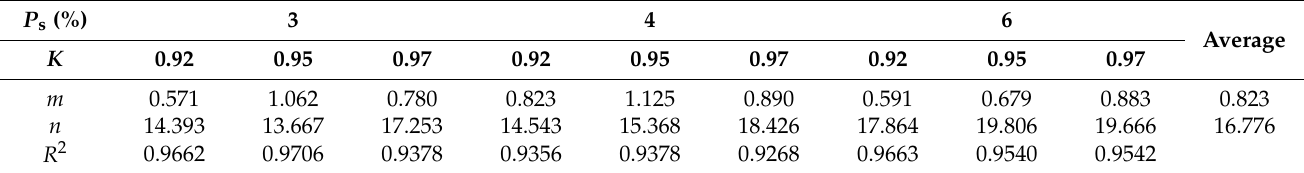
Table 5. Prediction equation regression coefficient of fatigue life N of cement-stabilized